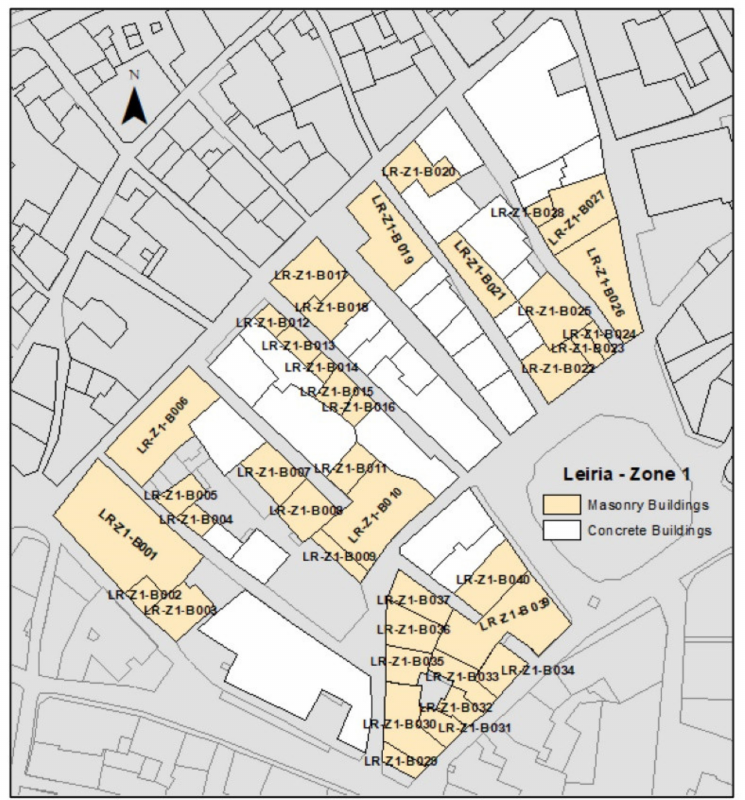
Figure 4. Region of study (Zone 1), emphasizing masonry-based constructions and the key assigned during the data acquisition